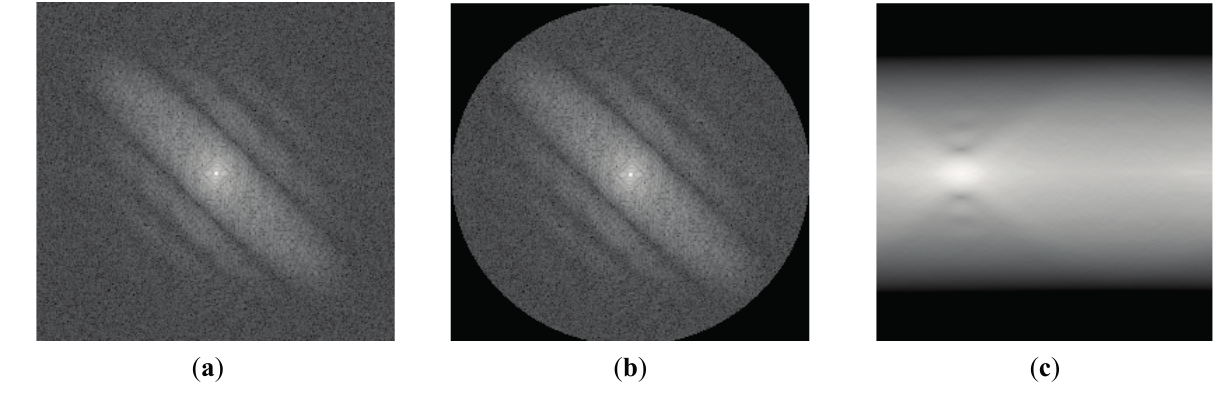
Figure 7. Demonstration of selected area for Radon transform in our research: ( a ) original power spectrum of a motion-blurred image; ( b ) selected region for motion direction estimation, and ( c ) Radon transform of selected region (horizontal and vertical axes are (cid:2016) and (cid:2025) of Equation